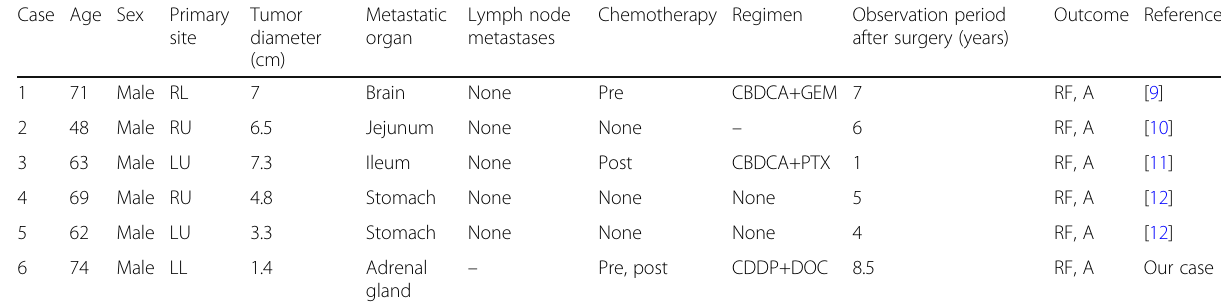
Table 1 Resected cases of stage IV pulmonary pleomorphic carcinoma Case Age